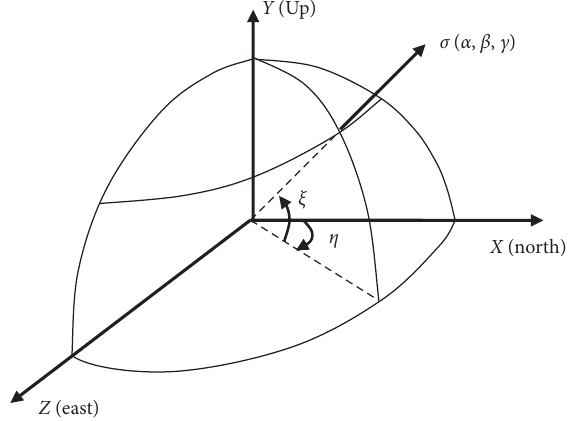
Figure 5: The principal stress axis represented in geographic co- ordinates and computational